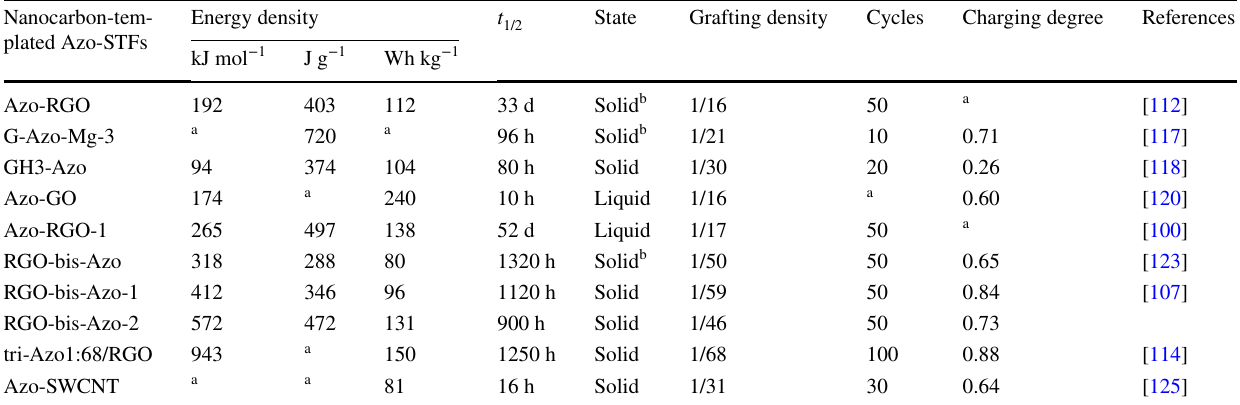
Table 2 Parameters related to nanocarbon-templated